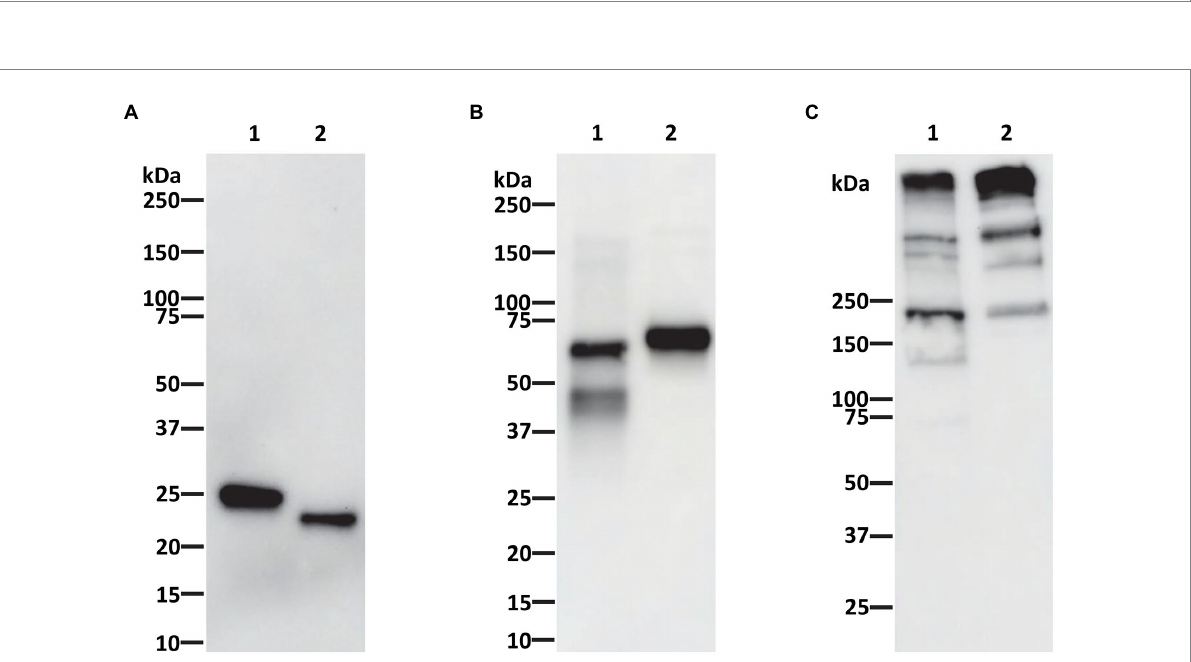
FIGURE 4 Western blot analysis of purified P-4H2 IgM. Recombinant 4H2 IgM purified from Nicotiana benthamiana leaves was separated under reducing (A,B) or non-reducing (C) conditions by SDS-PAGE and proteins were then transferred to PVDF membranes. The membranes were incubated with antibodies against human kappa chain (A,C) or human mu chain (B) to verify protein identity and IgM assembly. Lane 1, Humanized P-4H2 IgM (1 μ g per lane in A , 0.5 μ g per lane in B,C ), Lane 2, Human kappa IgM isotype control (1 μ g per lane in A , 0.5 μ g per lane in B,C